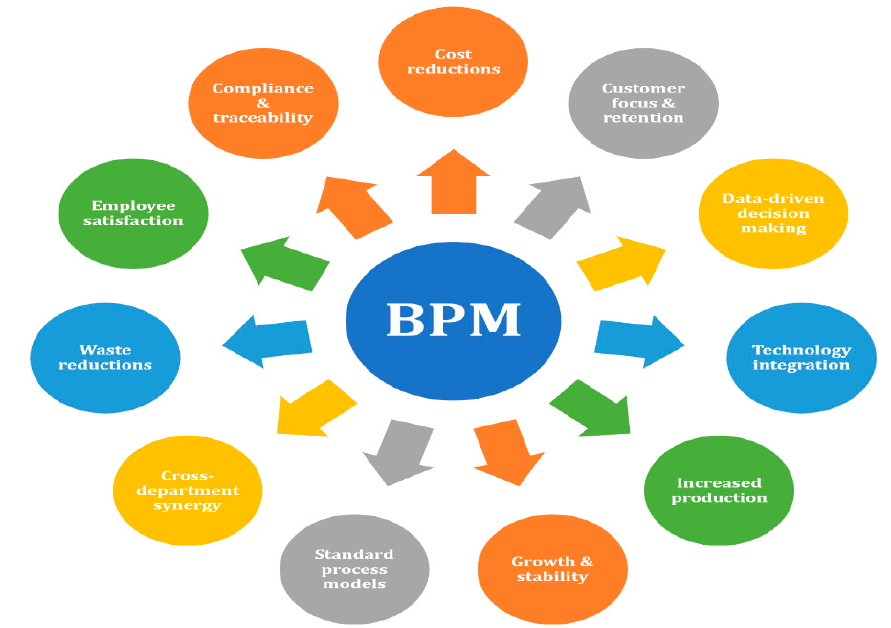
Figure 3. Benefits offered by business process management. Designs 2020 , 4 , 17